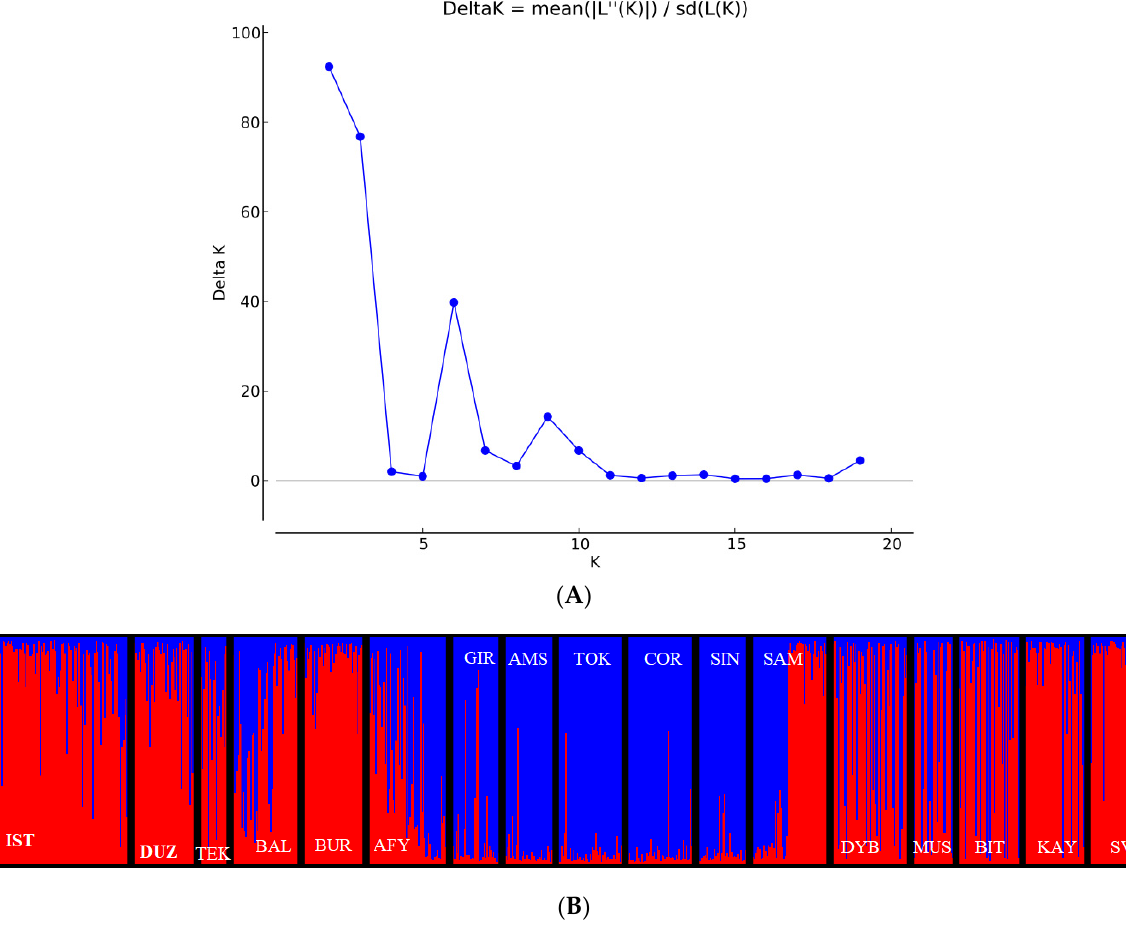
Figure 4. ( A ) Plot of ( ∆ K) values for each K from 1 to 20. ( B ) Clustering analysis by structure for the full-loci dataset assuming K = 2. Blue: Cluster I; Red: Cluster II; Population name abbreviations are labeled below the structure result (Marmara Region (MRM): ˙Istanbul/Çatalca—IST; Tekirda˘g/Saray—TEK; Balıkesir—BAL; Bursa—BUR; Black Sea